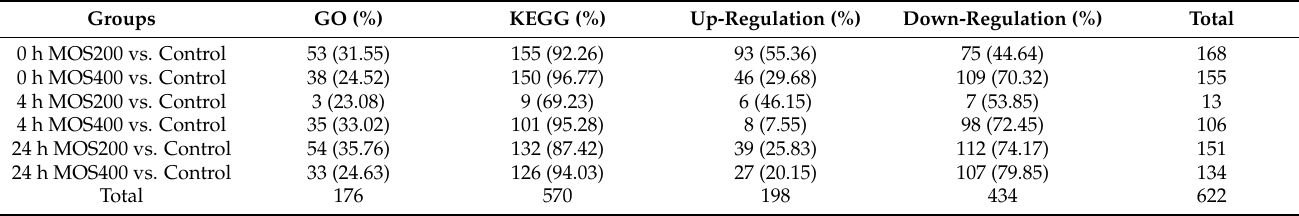
Table 2. Data quality of DGE